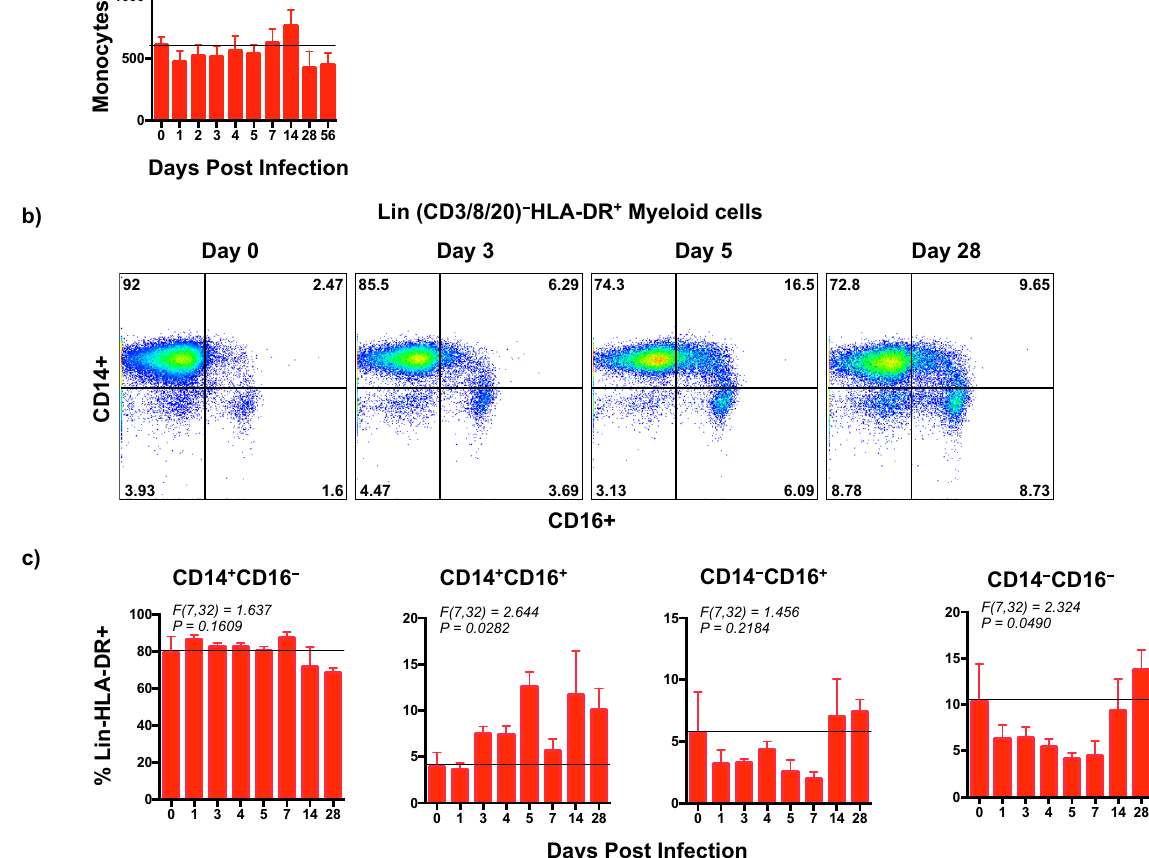
Figure 5. Proportions of pro-inflammatory monocyte subsets are significantly elevated during coinfection with ZIKV and DENV-2. ( a ) Absolute number of monocytes in peripheral blood, ( b ) representative dot plots showing changes in monocyte subsets in peripheral blood that was collected longitudinally from a single animal at day 0, 3, 5, and 28 after coinfection with ZIKV and DENV-2. Monocyte subsets were discriminated based on the expression of CD14 and CD16 on Lin (CD3/CD8/CD20) − HLA-DR + myeloid cells. ( c ) Kinetics of peripheral blood monocyte subsets in rhesus macaques that were coinfected with ZIKV and DENV-2. Line represents day 0 values. Statistical differences were determined using One-way ANOVA and p < 0 . 05 was considered significant. Error bars represent standard